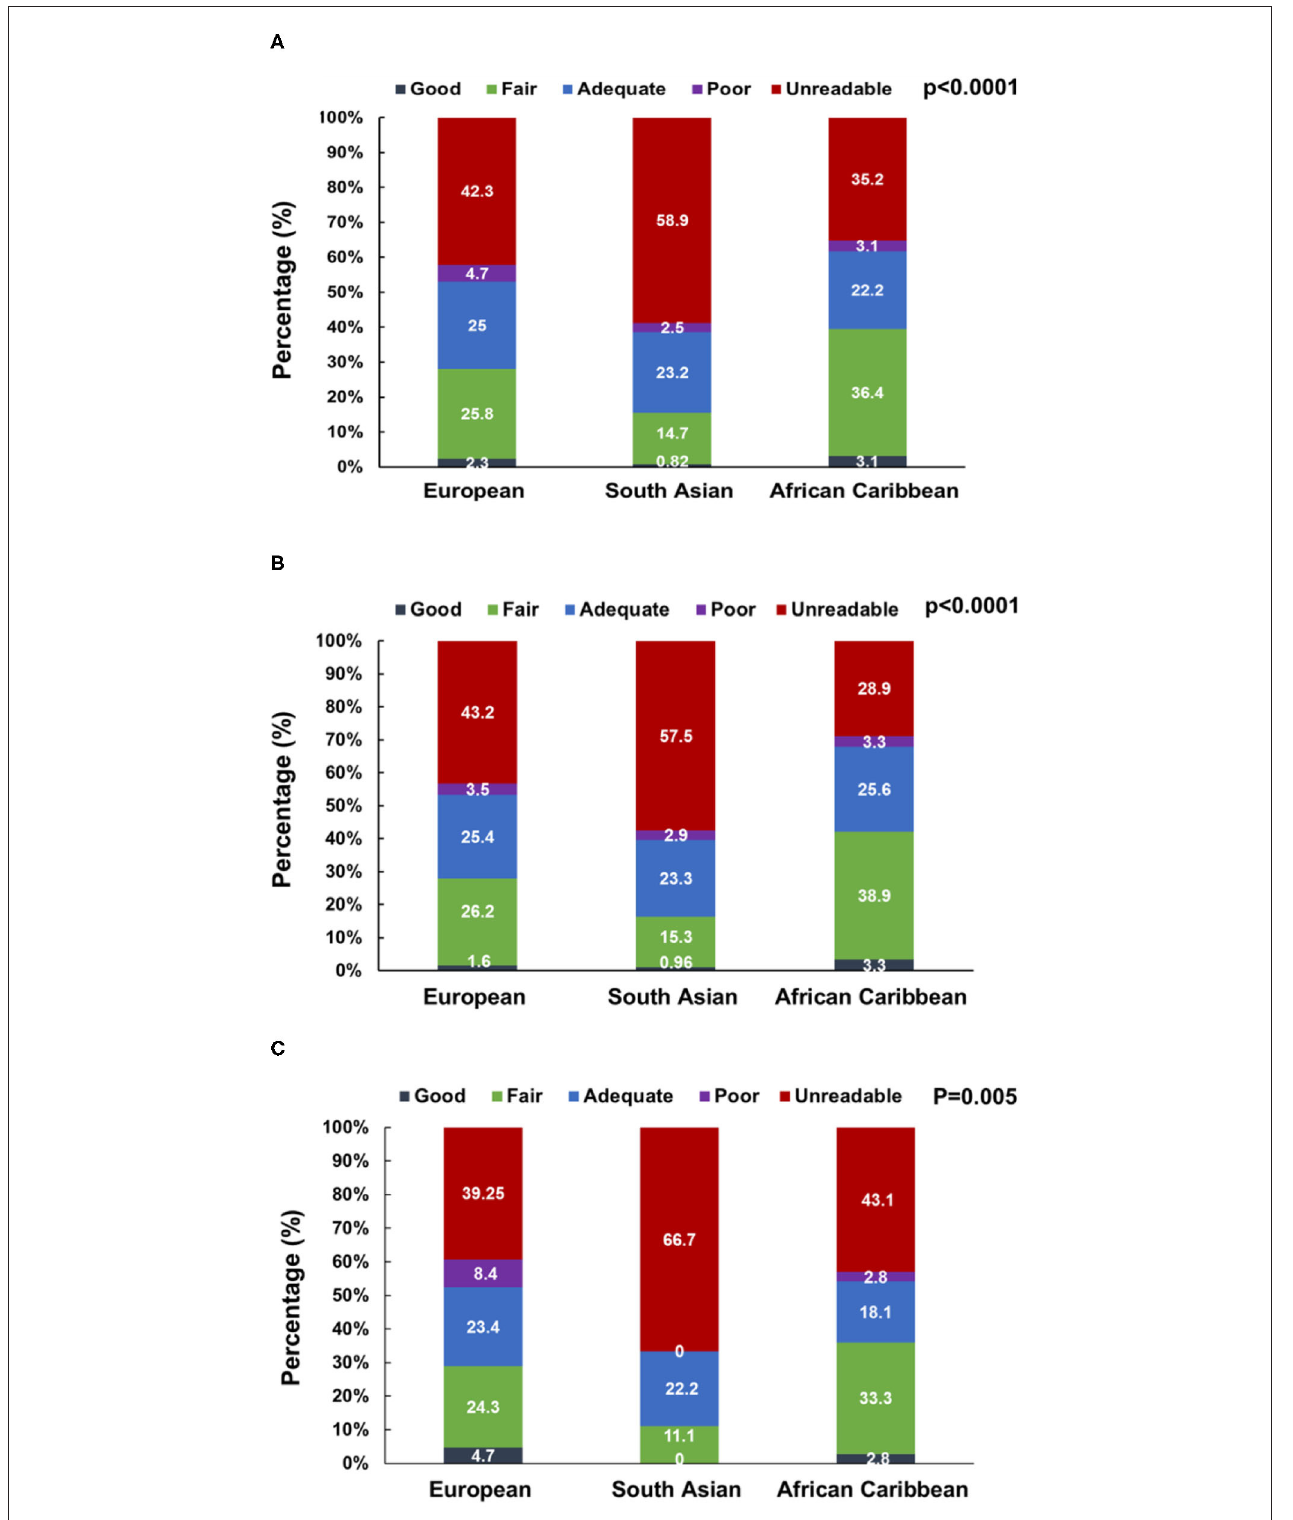
FIGURE 2 | 3D dataset image quality score stratified by ethnicity in the overall SABRE population [ N = 1,001, (A) ] and among men [ N = 768, (B) ] and women [ N = 233, (C) ] participants. Numbers are percentages.